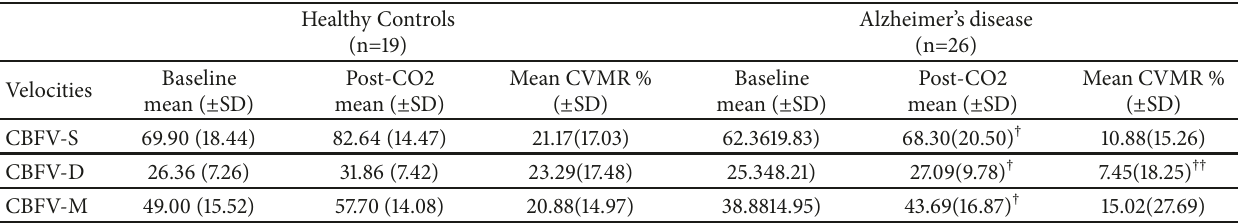
Table 2: Baseline, post-CO2 test cerebral blood flow velocities, and calculated